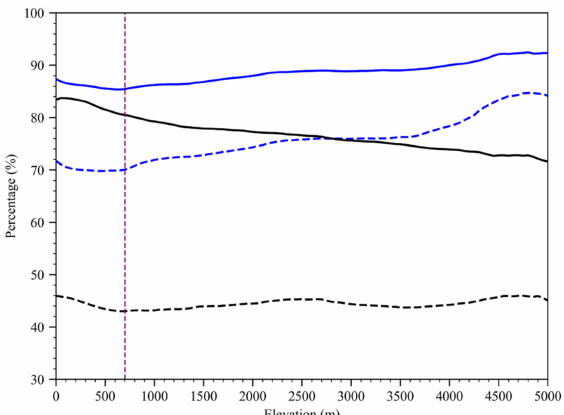
Figure 7. Detection rate of cloudy data (solid curves) and rejection rate of clear-sky data (dashed curves) for the new thresholds (black curves) and old thresholds (blue curves) above different topographic heights in East Asia from 1 to 31 August